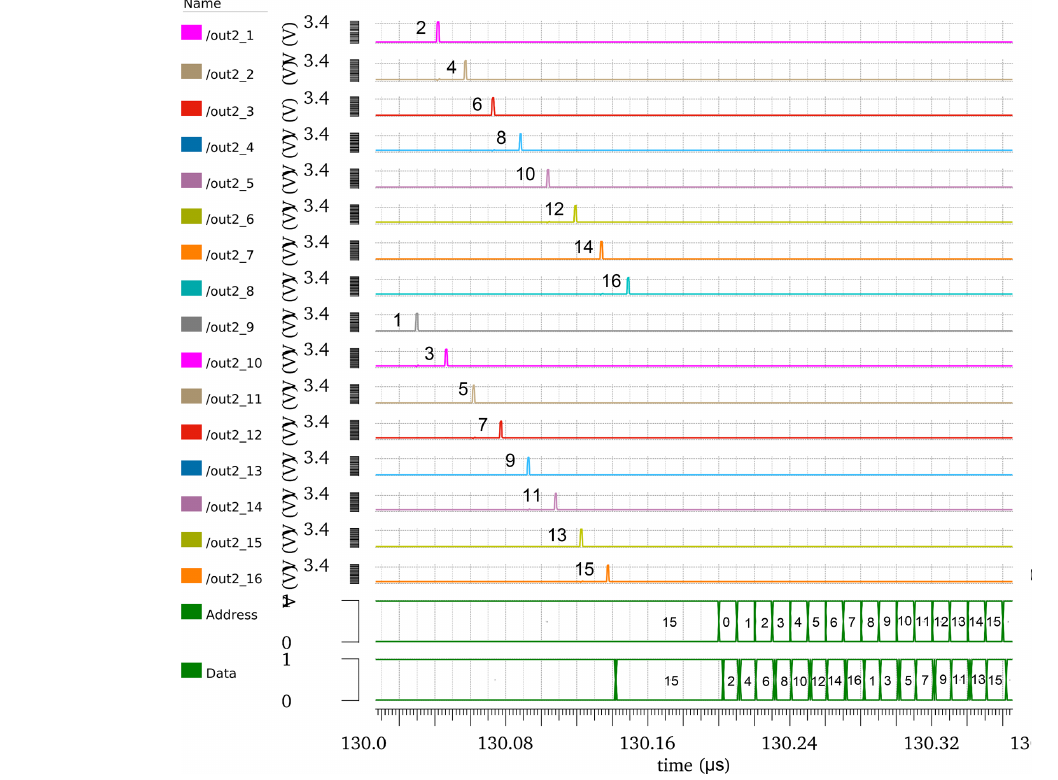
Figure 22. Simulation of the WTA and memory. The terms out2_1 to out2_16 represent the outputs of the WTA cells. The decoder changes the address of the memory. The data represent the order of the outputs of the WTA cells, which are saved in the